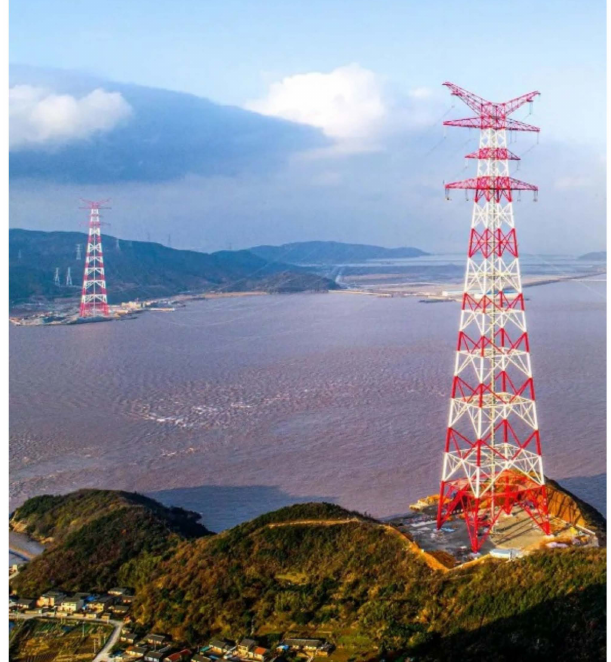
Figure 1. Engineering application of